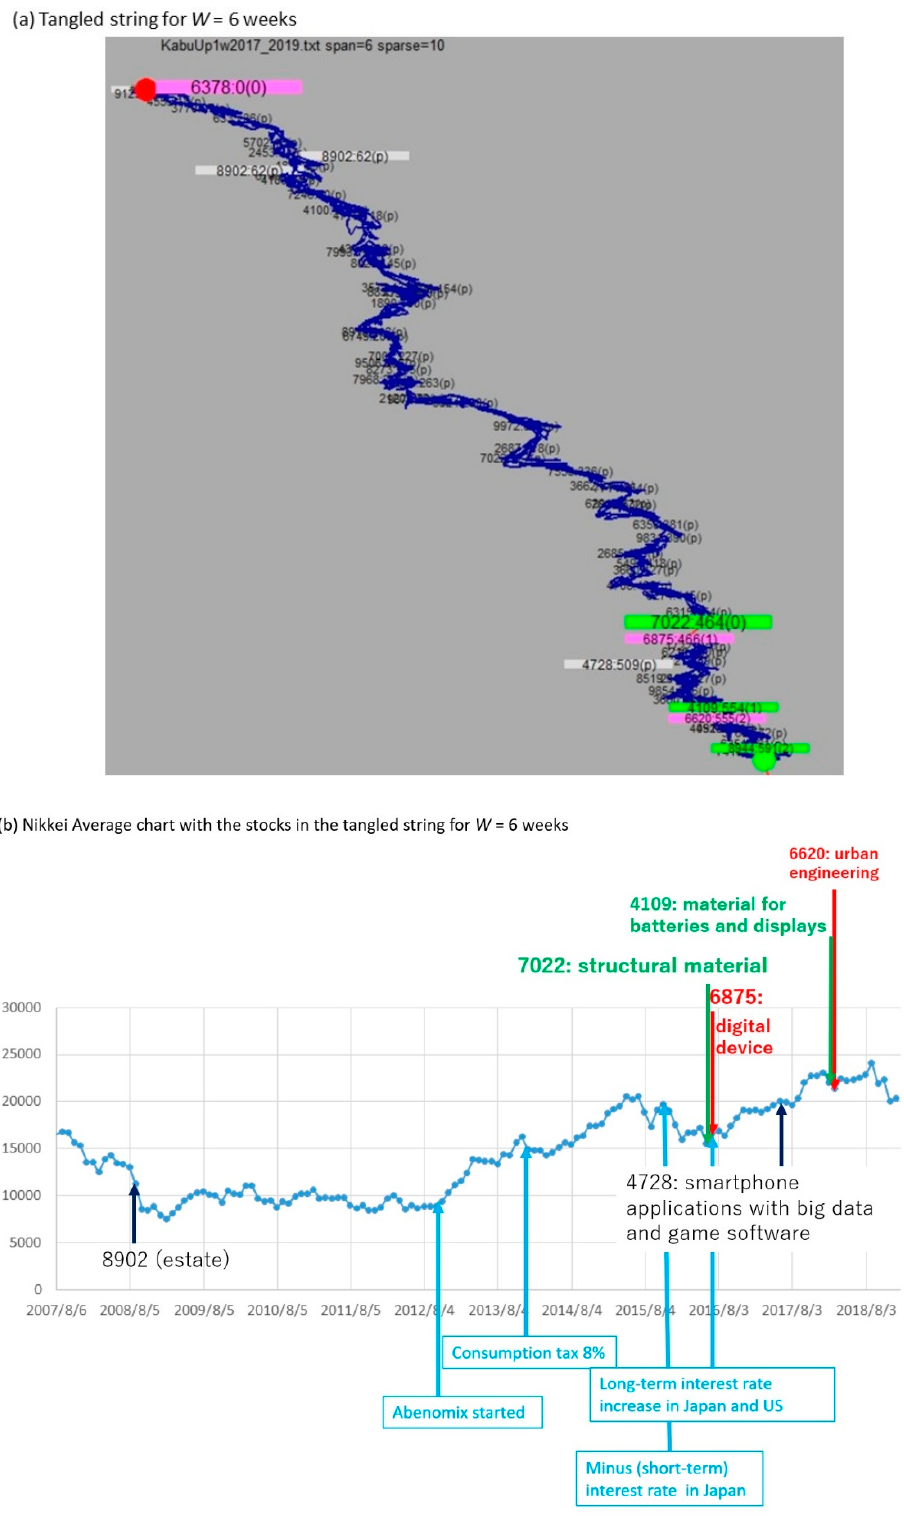
Figure 6. Result of TS for W = 6 (weeks) for the top-10 data. ( a ) and ( b ) mean the same as in Figure 4, respectively.